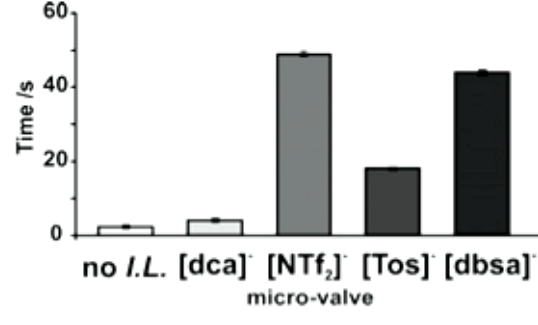
Figure 6. Actuation times of photo-responsive ionogel valves under uniform white light illumination as a function of the IL anion [18] (Reproduced by permission of The Royal Society of